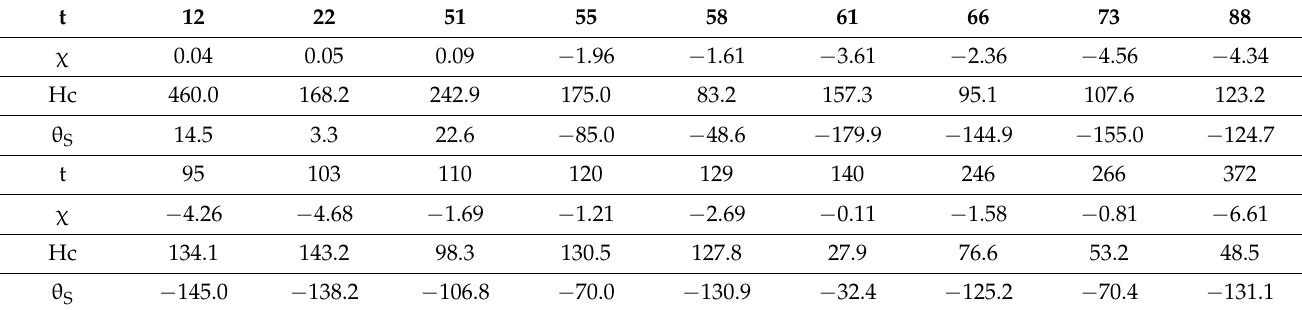
Table 1. CoFeB thickness (t, nm) depending on the highest MOKE susceptibility ( χ , mdeg/Oe), coercivity (Hc, Oe), and MOKE saturation rotation angle ( θ S , mdeg) of the CoFeB thin films on AAO